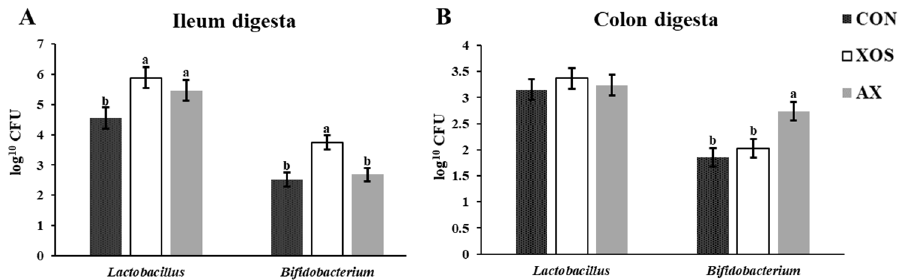
Figure 8. Effects of xylo-oligosaccharides and arabinoxylans on gut microbiota community in weaned pigs. Note: ( A ) ileum digesta; ( B ) colon digesta. a, b Significant differences ( p < 0.05) between different letters in the same row of shoulder labels (n = 6); CON, a control diet; XOS, a diet containing 1% xylo-oligosaccharide; AX, a diet containing 1% arabinoxylans; SEM, standard error of the mean.